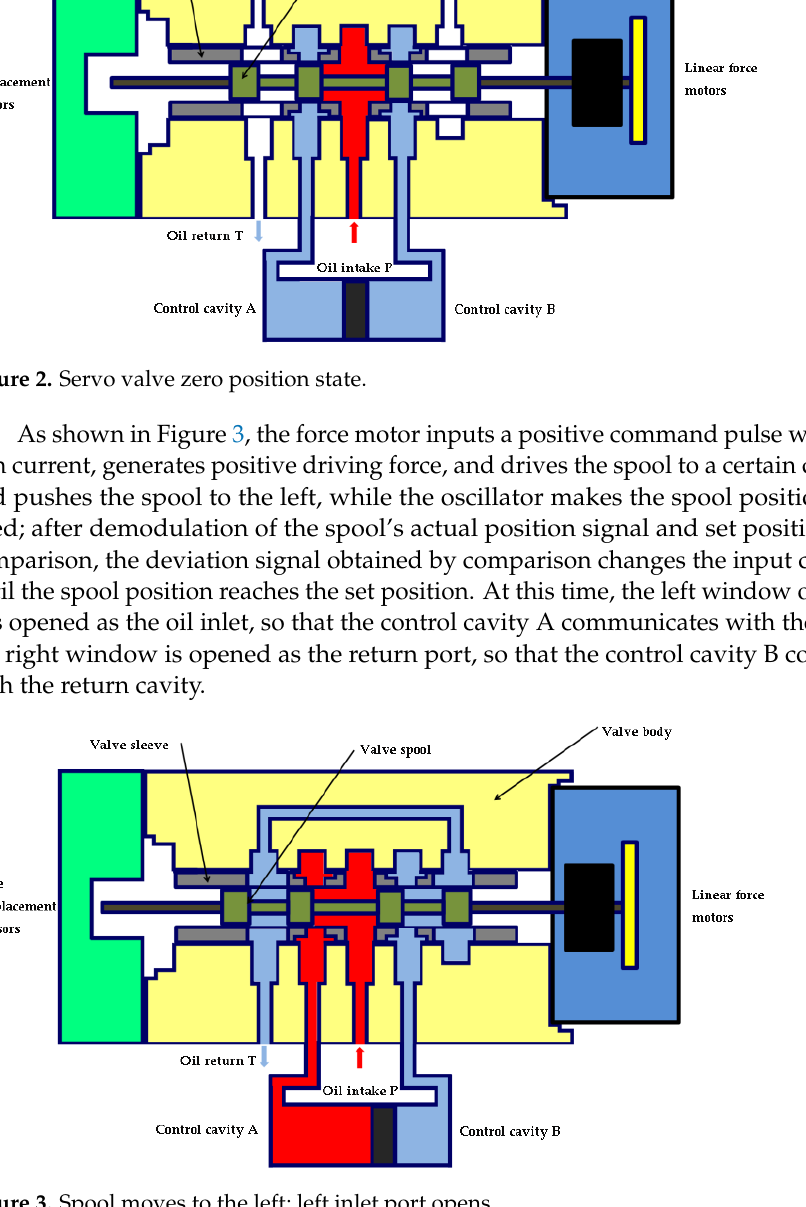
Figure 3. Spool moves to the left; left inlet port opens.